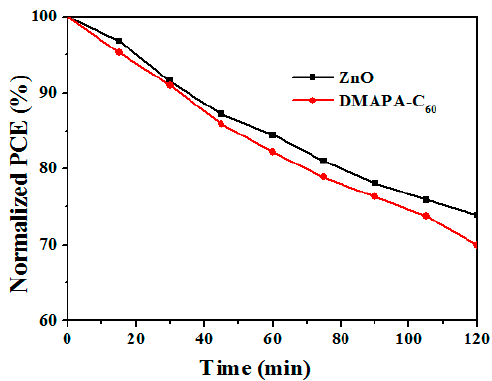
Figure 5. Stability curves of ZnO and DMAPA- C 60 devices under continuous heating at 130 °C for 120 min.